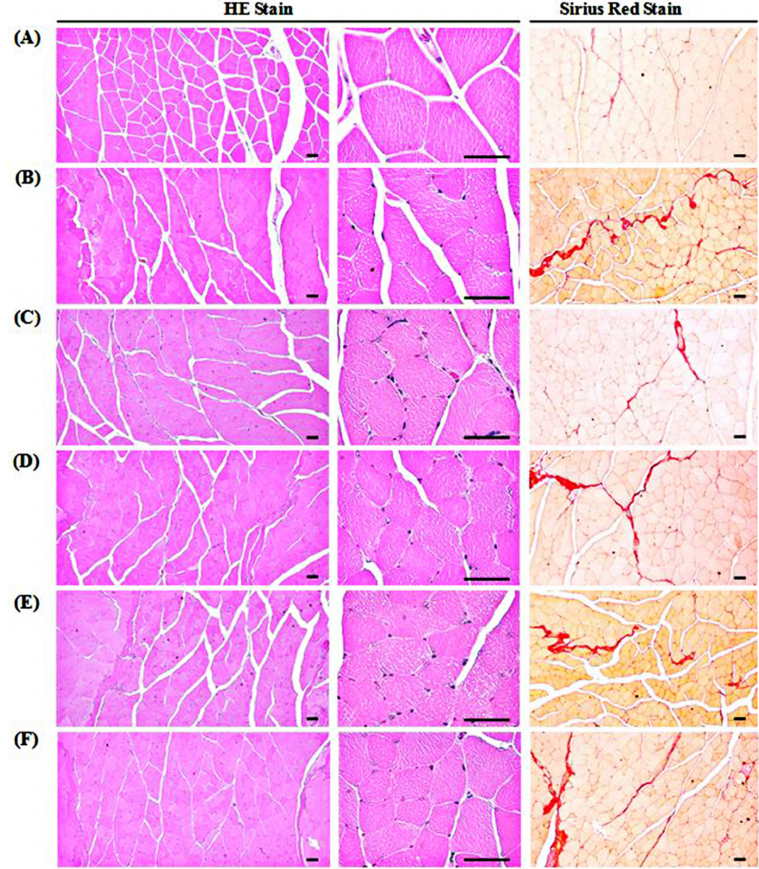
Figure 7. Representative gastrocnemius muscle histology. ( A ) Intact vehicle control (distilled water administered and treated with saline). ( B ) GLU control (distilled water administered and treated with DEXA). ( C ) Oxymetholone (50 mg/kg oxymetholone administered and treated with DEXA as reference). ( D ) TCcp500 (500 mg/kg TCcp administered and treated with DEXA–higher dose treated mice). ( E ) TCcp250 (250 mg/kg TCcp administered and treated with DEXA–middle dose treated mice). ( F ) TCcp125 (125 mg/kg TCcp administered and treated with DEXA–low dose treated mice). TCcp = tart cherry (Fruit of Prunus cerasus L., Rosaceae) concentrated powder. GLU = glucocorticoid. DEXA = dexamethasone. Arrows indicated collagen fibers deposited as focal fibrosis. Scale bars = 40 µ